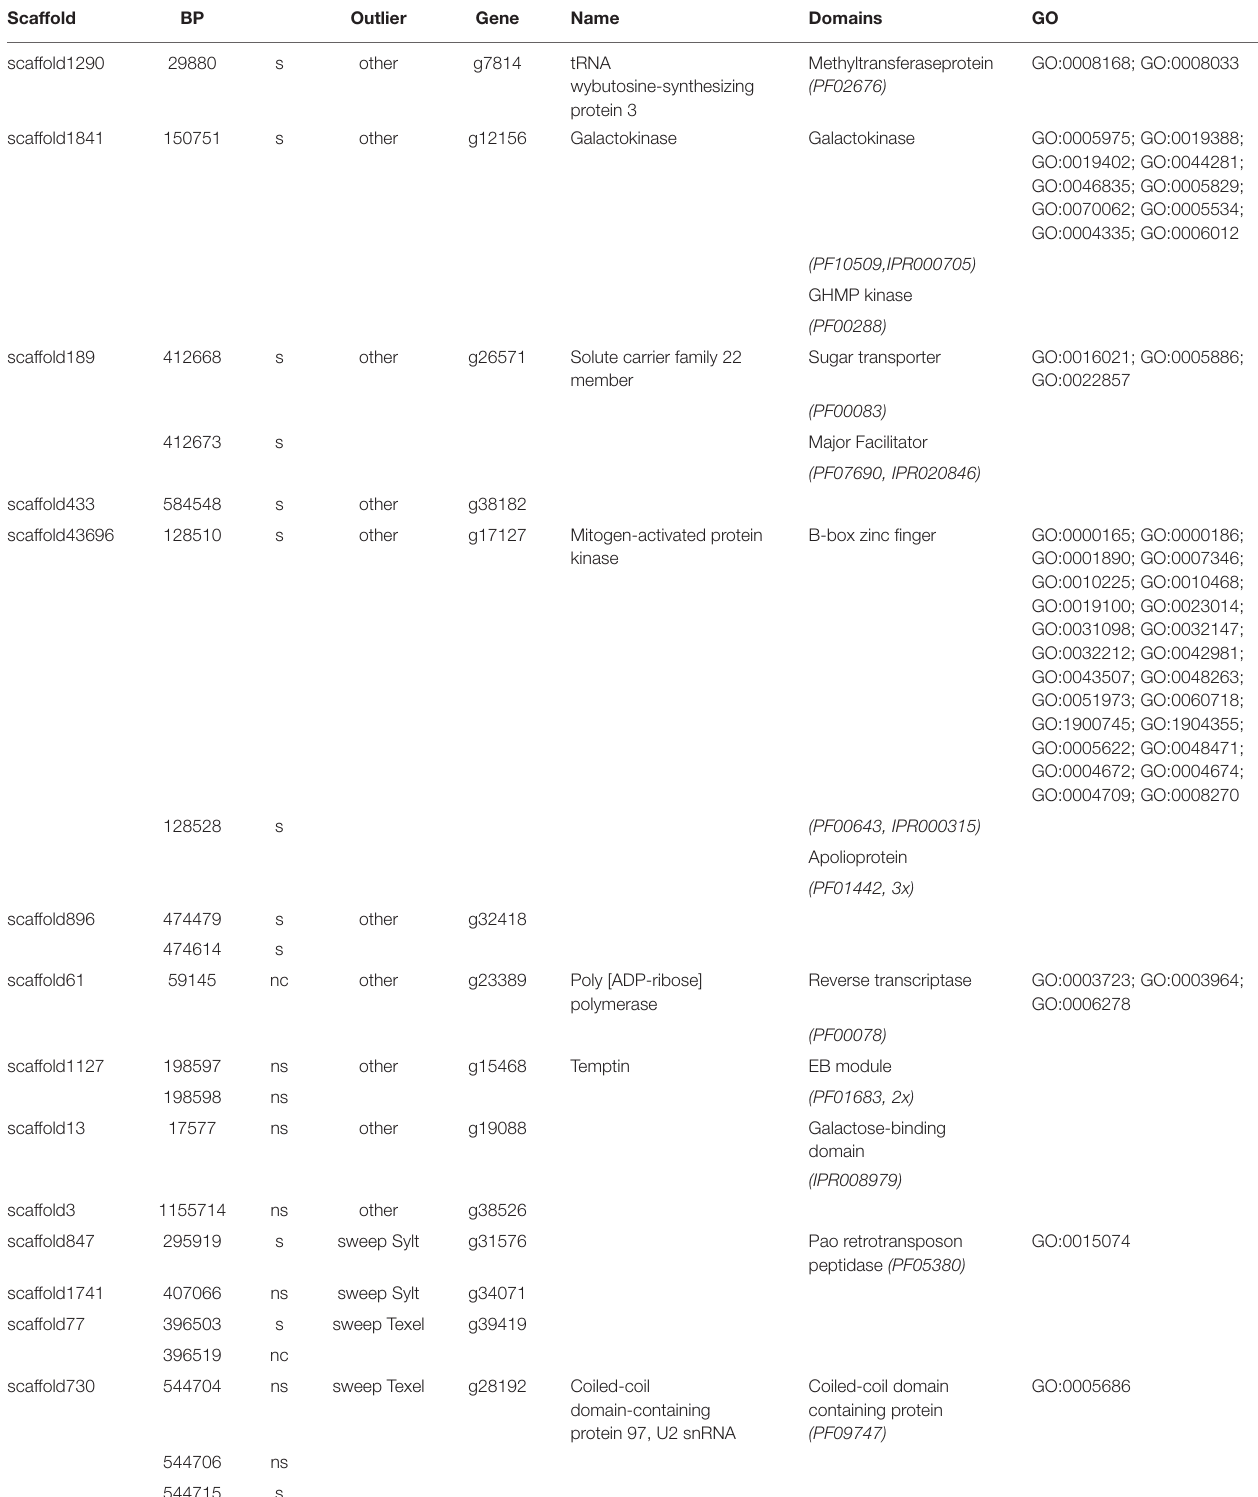
TABLE 1 | Annotation of outlier SNPs within gene regions giving the genomic scaffold and position in bp, substitution type, outlier type and gene annotation with conserved domain signatures and gene ontology. Scaffold BP